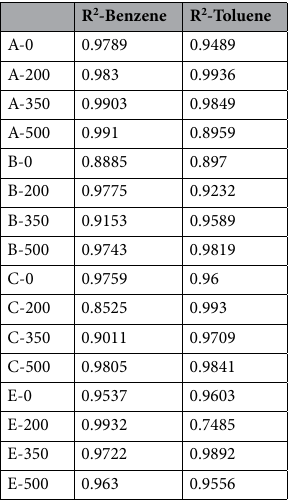
Table 2. The determination coefficients (R 2 ) for the regression of